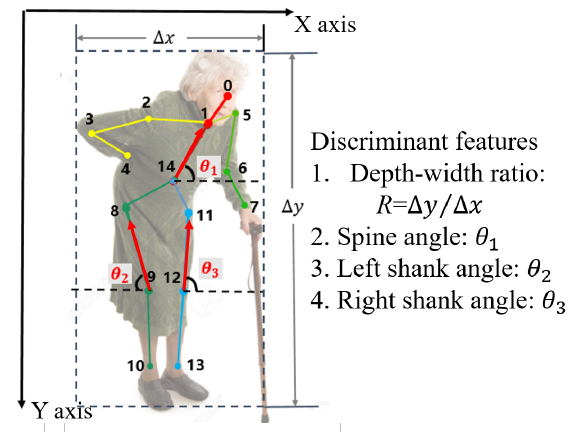
Fig. 3. Schematic diagram of the discriminative features of human fall